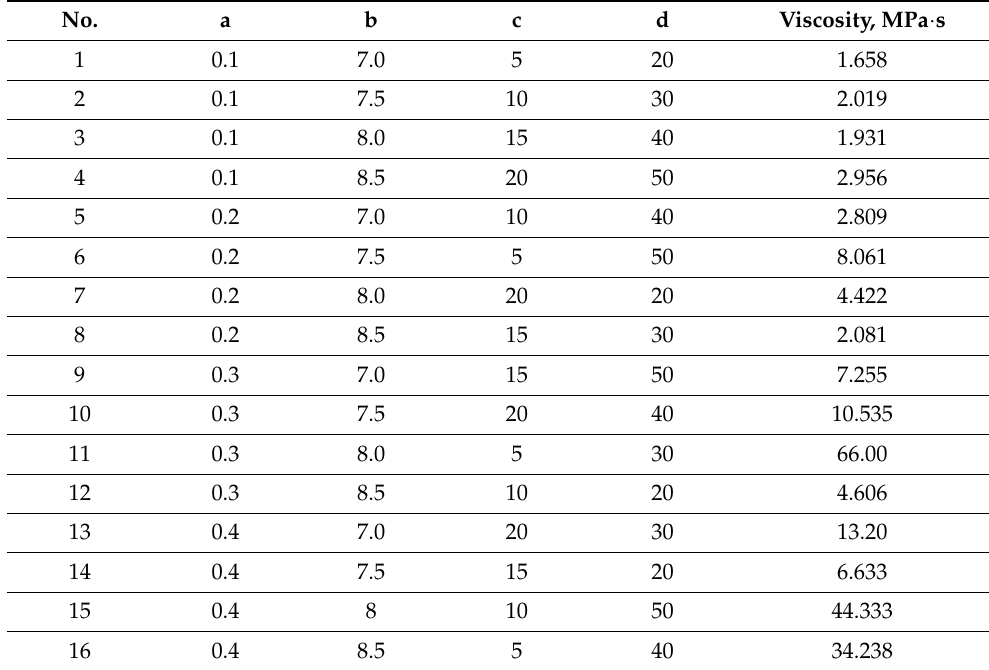
Table 1. Numerical values of variable parameters and response function values. No. a